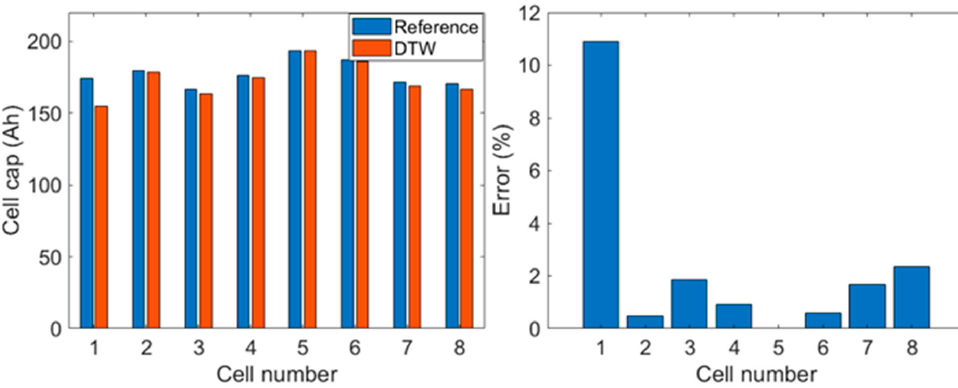
Figure 13. Estimation results and estimation error with curve-matching method (interface data).